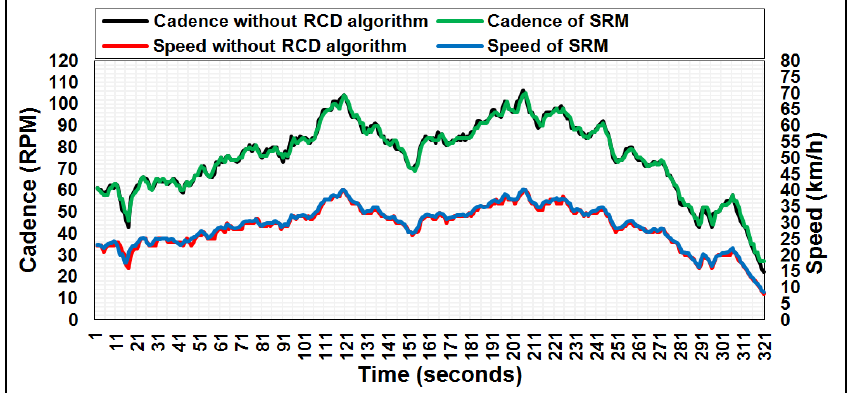
Figure 3. Real time measurements of bike speed and cadence for the proposed system and the SRM